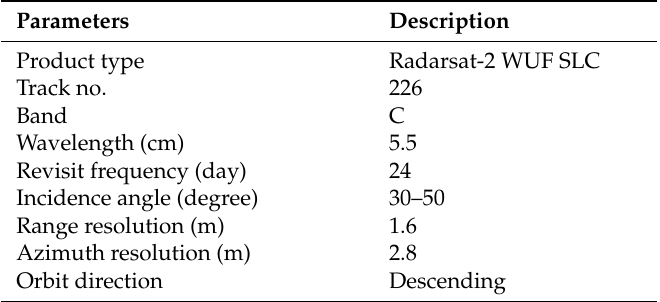
Table 1. Parameters of Radarsat-2 WUF SLC